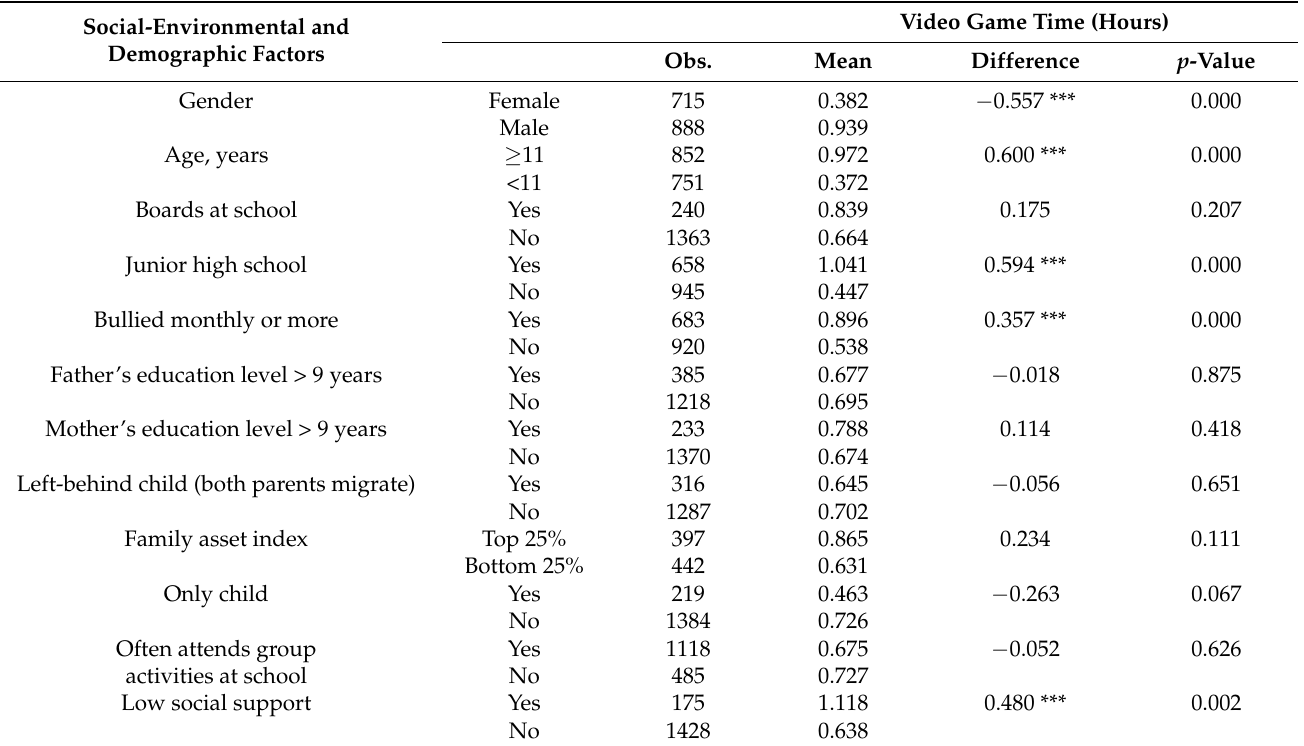
Table 2. Descriptive analysis of video game time: comparisons between different types of